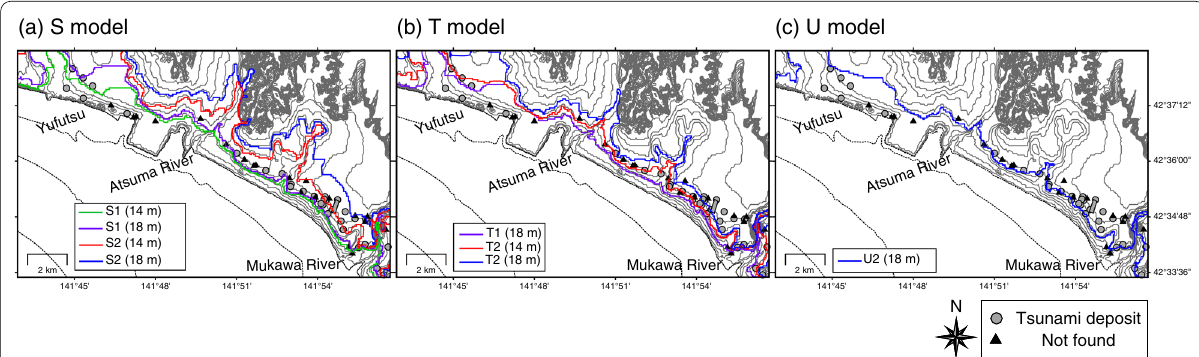
Fig. 8 Calculated inundation limit using the S, T, and U models at Yufutsu–Atsuma–Mukawa. Comparison of computed inundation limit with tsunami deposit distribution reported by Takashimizu et al. (2007): a S model, b T model, c U model. The color lines show the inundation limits of each model. The green, purple, red, and blue lines in a show S1 with a 14 m slip, S1 with an 18 m slip, S2 with a 14 m slip, and S2 with an 18 m slip, respectively. The purple, red, and blue lines in b show T1 with an 18 m slip, T2 with a 14 m slip and T2 with an 18 m slip, respectively. The blue line in c shows U2 with an 18 m slip. The gray circles and rectangles indicate the locations where tsunami deposits were found by Takashimizu et al. (2007). The black triangles show the sites where tsunami deposits are not